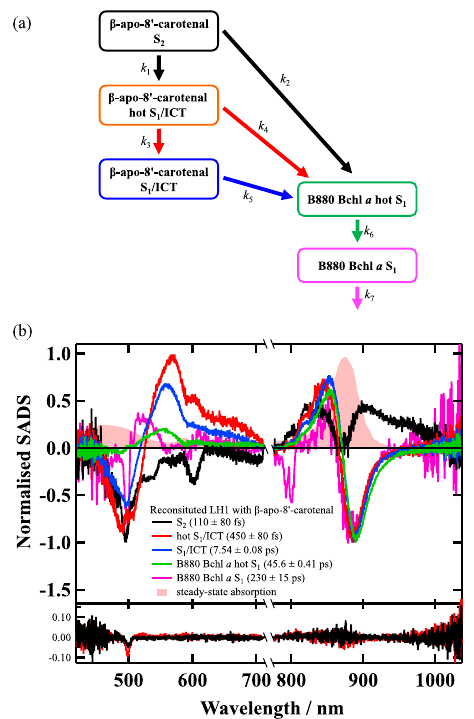
Fig. 6 Target model and SADS obtained by the target analysis against the entire observed dataset of femtosecond time-resolved absorption spectra of Re β apo. a A target model used to analyze the femtosecond time-resolved absorption spectra of Re β apo in the visible and near-infrared spectral region. b The result of target analysis applied to the entire observed dataset of femtosecond time-resolved absorption spectra of Re β apo. The fi rst (solid black line) and second (solid red line) right singular value vectors of the residual matrix, which corresponds to the residuals of the fi ttings, is shown at the bottom. The negative peak around 500 nm in the residuals is due to the scattering of the excitation light. Apart from this peak no meaningful spectral pattern is observed in the residuals, a fact which supports the successful spectral fi ttings. The steady-state absorption spectrum of Re β apo is also shown for